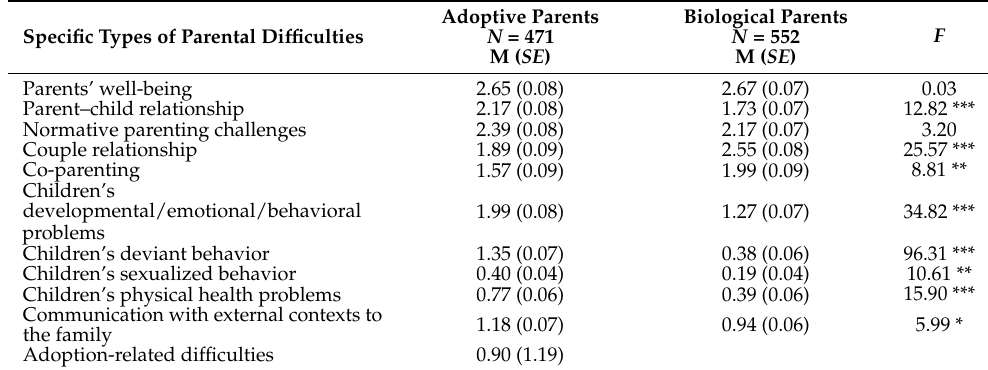
Table 3. Specific Types of Parental Difficulties by Family Type (Adoptive vs. Biological Parents): Descriptive Statistics and Group